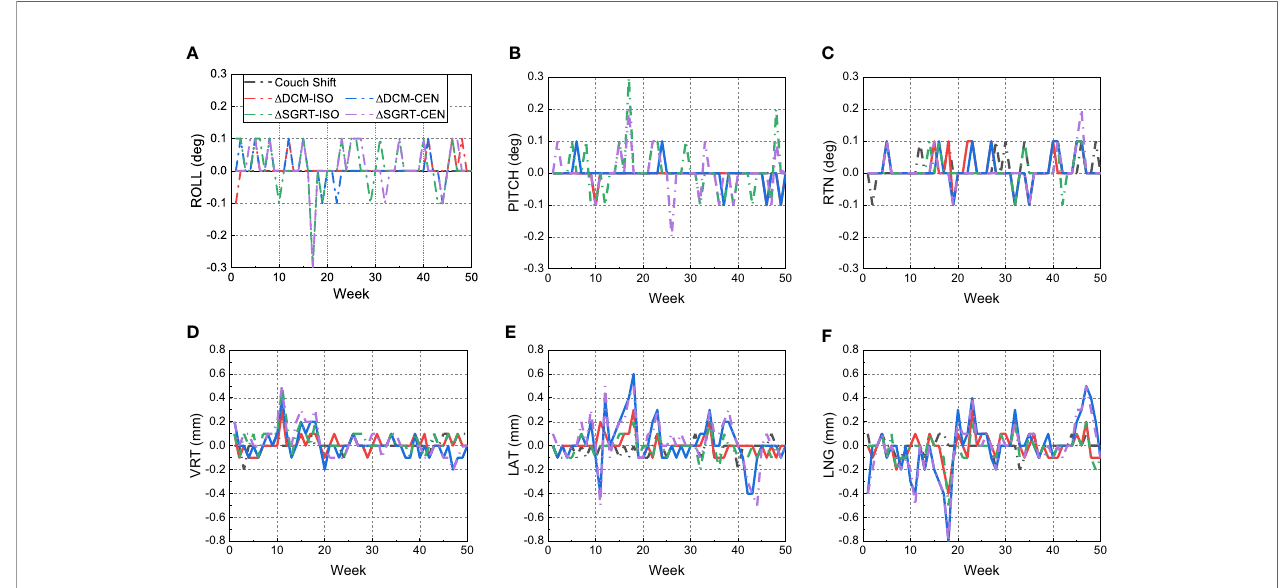
FIGURE 3 | Discrepancies from CBCT-guided shifts to the actual couch shifts and AlignRT trackings over 50 weeks. The trends are listed in six dimensions respectively: (A) ROLL (deg), (B) PITCH (deg), (C) RTN (deg), (D) VRT (mm), (E) LAT (mm) and (F) LNG